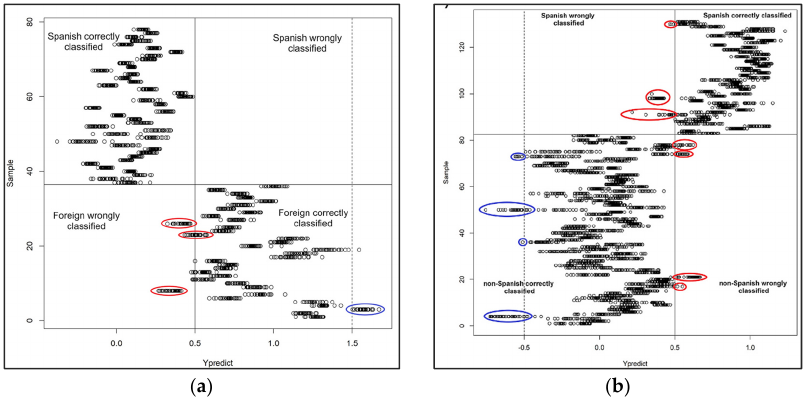
Figure 7. Plots of the PLS-DA for the geographical discrimination of ( a ) mangoes; ( b ) avocados. Figures are reprinted with permission from Ref. [121,122], respectively.